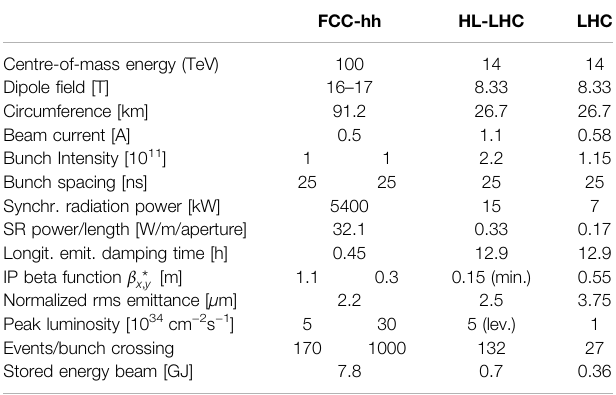
TABLE 2 | Key parameters of FCC-hh compared with the HL-LHC and